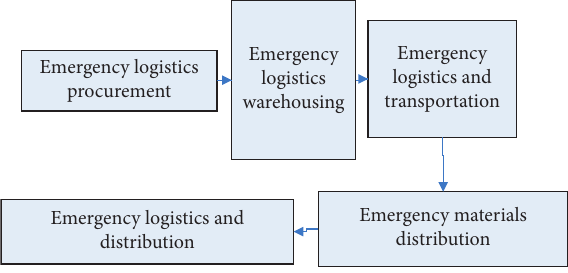
Figure 1: Emergency logistics system